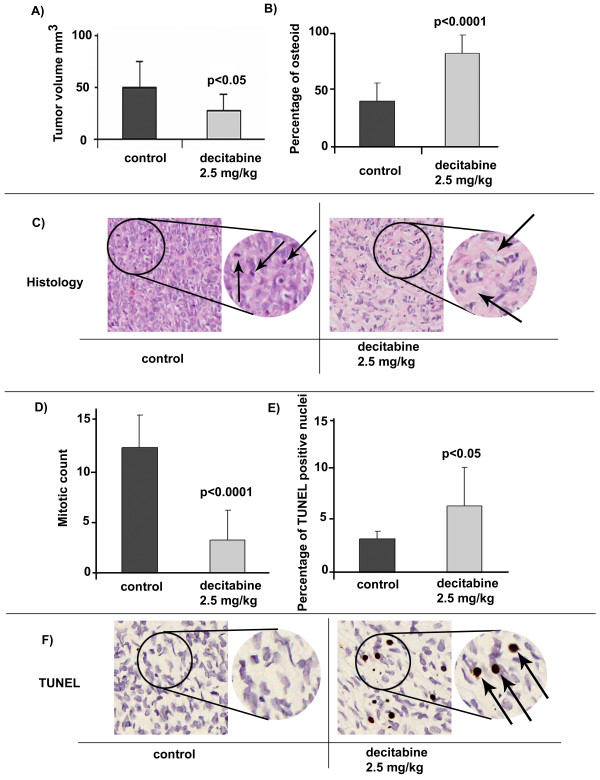
Induction of differentiation and apoptosis by decitabine treatment of U2OS in vivo. A), Decitabine effects on tumor volumes in vivo. The results compare tumor volumes in control xenografts to decitabine treated xenografts as described in methods. Each column is the Mean of tumor volumes measured in 12 xenograft tumors. There was a significant decrease (p < 0.05) in tumor volumes as a result of decitabine treatment. B), Osteoid assessment in vivo. Each column is the Mean of osteoid evaluation of 9 sections. There was significant increase (p < 0.0001) in osteoid formation as a result of decitabine treatment. C), Representation images of H&E sections. Control xenograft tumors (left) show solid sheets of poorly differentiated cells with minimal osteoid (image magnification × 100). Decitabine treated tumors  shows less dense cell population and increased areas of osteoid seen as light pink and lacy matrix with the nuclei of osteoblasts sitting closer to the produced matrix (image magnification × 100). The arrows in the enlargement  show the osteoid matrix surrounding osteoblasts (defined as eosinophilic osteoid-like material). C), And D), Mitotic count as identified in the same sections used to asses for osteoid evaluation. Each column is the Mean mitotic count in 9 sections (a minimum of 1100 nuclei were scanned per section). Decitabine treatment resulted in a significantly lower mitotic count (p < 0.0001). The arrows in the enlargement image in C (left) indicate mitotic nuclei. E), Results for apoptosis analysis by TUNEL assay. Each column is the Mean count of TUNEL positive nuclei seen in 9 images representing 9 sections (≥1000 nuclei were scanned per section). There was a significant increase (p < 0.05) of apoptotic cells as a result of decitabine treatment. F), Representation images from TUNEL assay of control tumors (left) and decitabine treated tumors [50] (image magnification × 200). The arrows in the enlargement image show the TUNEL-positive nuclei (apoptotic nuclei). Error bars indicate standard deviation from the Mean values and p-values are based on comparison between control and decitabine treated tumors using student t-test.